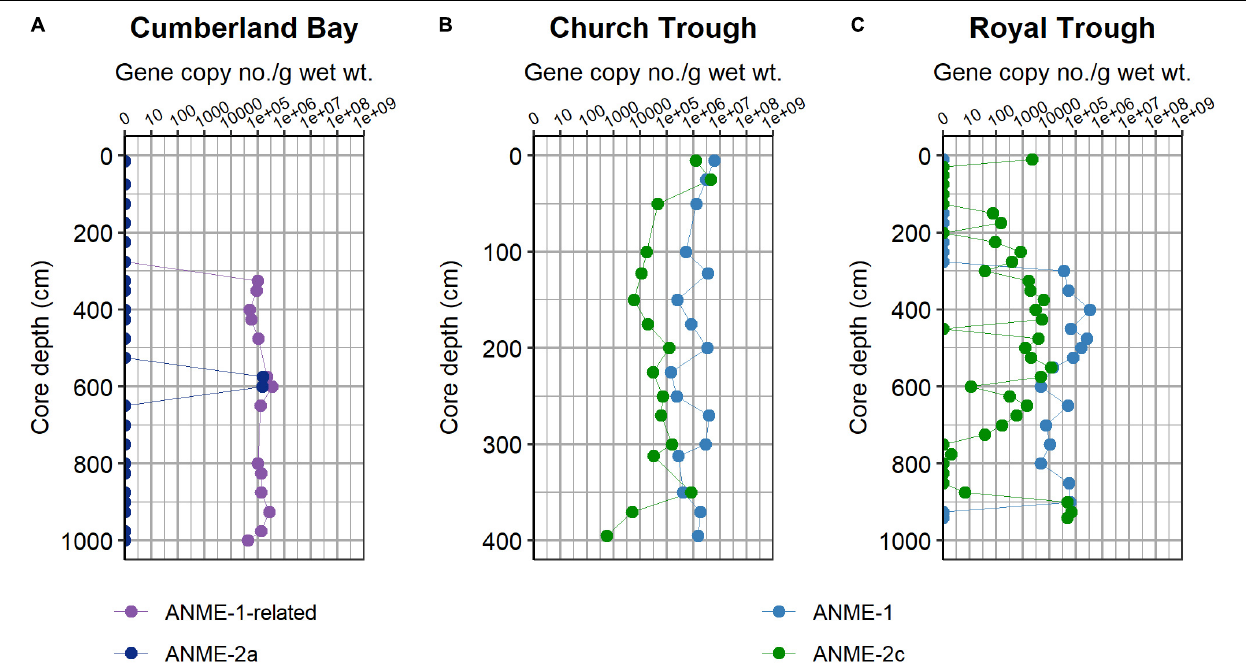
FIGURE 4 | Abundance of ANME phylotypes in South Georgia sediments. Quantitative PCR analyses of mcrA gene copy numbers of (A) ANME-1-related and ANME-2a in Cumberland Bay, and mcrA copy numbers of ANME-1 and ANME-2c in (B) Church Trough and (C) Royal